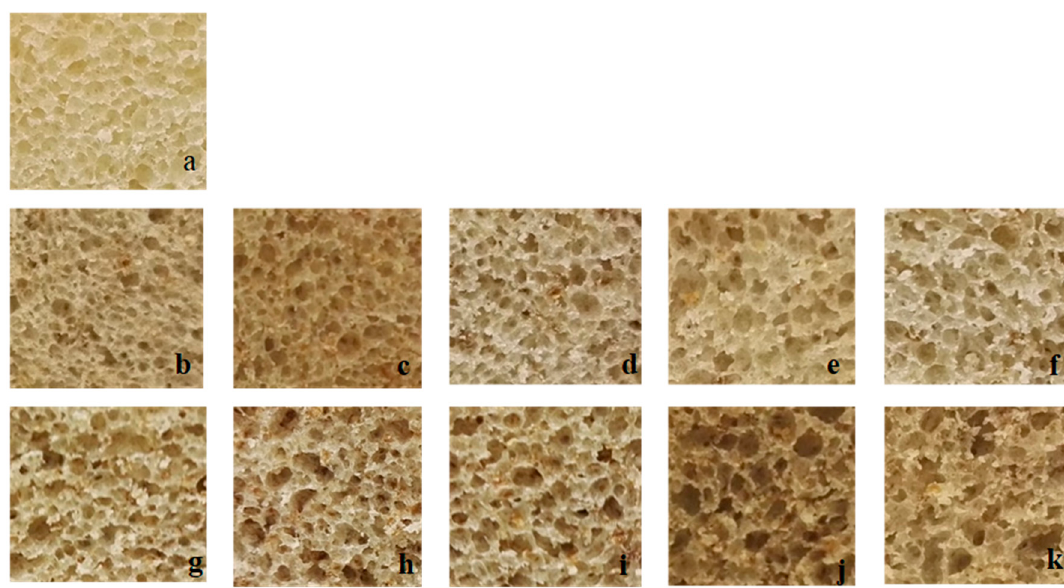
Figure 2. Effect of the incorporation of various types of chia flour on the central slice appearance. Bread formulation: Control ( a ); Whole chia flour 5% ( b ); semi-defatted chia flour with mucilage 5% ( c ); defatted chia flour with mucilage 5% ( d ); semi-defatted chia flour without mucilage 5% ( e ); defatted chia flour without mucilage 5% ( f ); Whole chia flour 10% ( g ); semi-defatted chia flour with mucilage 10% ( h ); defatted chia flour with mucilage 10% ( i ); semi-defatted chia flour without mucilage 10% ( j ); defatted chia flour without mucilage 10% ( k ).